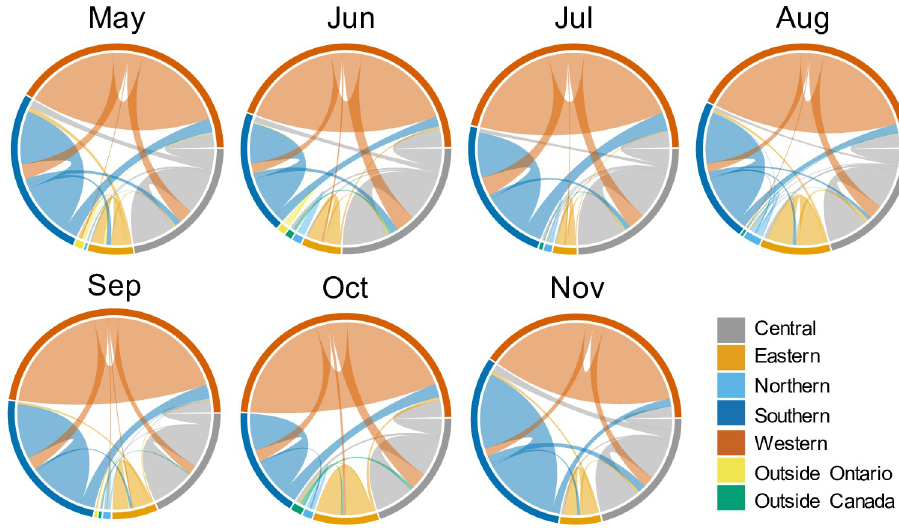
Fig 3. Within- and between-region movements of horses within each monthly network during the longitudinal study in 2015. Self-links represent movements within a region and links connecting two regions represents movements between regions. Central, eastern, northern, southern, and western regions refer to agricultural census regions in Ontario (see Fig 1 for defined areas).